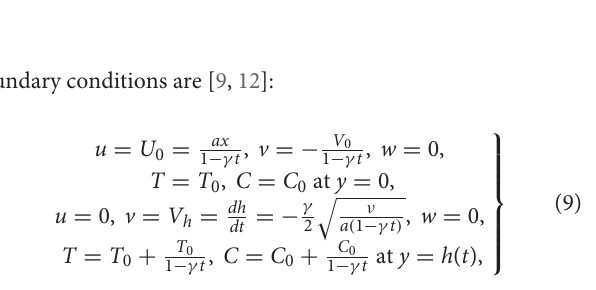
FIGURE 8 | Sketch of temperature distribution θ (η) for Dufour number Df .